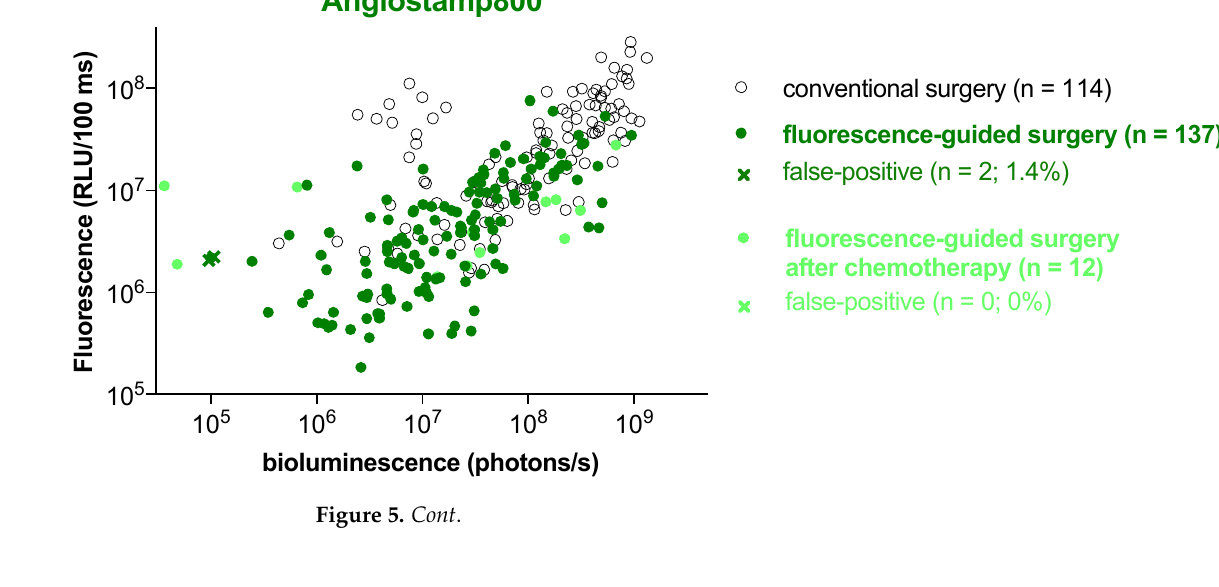
Figure 5. Angiostamp800 and Bevacizumab-IRDye 800CW showed fewer false-positive fluorescent signals than ICG. All fluorescent surgical nodules from mice with peritoneal carcinomatosis without or after chemotherapy were analyzed ex vivo by bioluminescence to determine their tumor status. Nodules with low or no bioluminescence signals were further analyzed to quantify luciferase ex- pression by measuring the presence of tumor cells. Data show a correlation between the biolumi- nescence and fluorescence of samples resected by conventional surgery (open black dots) or fluo- rescence-guided surgery (colored plain dots). Fluorescent nodules with a negative bioluminescence signal were considered false positives (colored crosses). The number of resected nodules and the percentage of false-positive residues is indicated for each probe, except for fluorescence-guided sur- gery with ICG after chemotherapy, which failed to resect additional tumor nodules because of the blurred fluorescence signal from ICG.